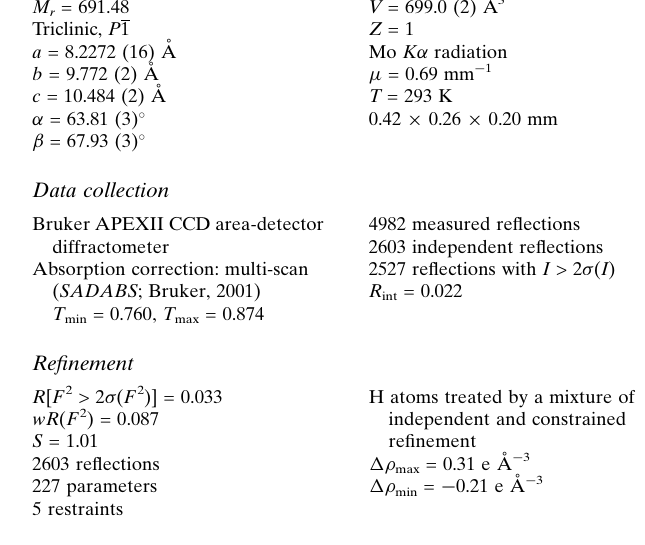
Bruker APEXII CCD area-detector diffractometer Absorption correction: multi-scan ( SADABS ; Bruker, 2001)